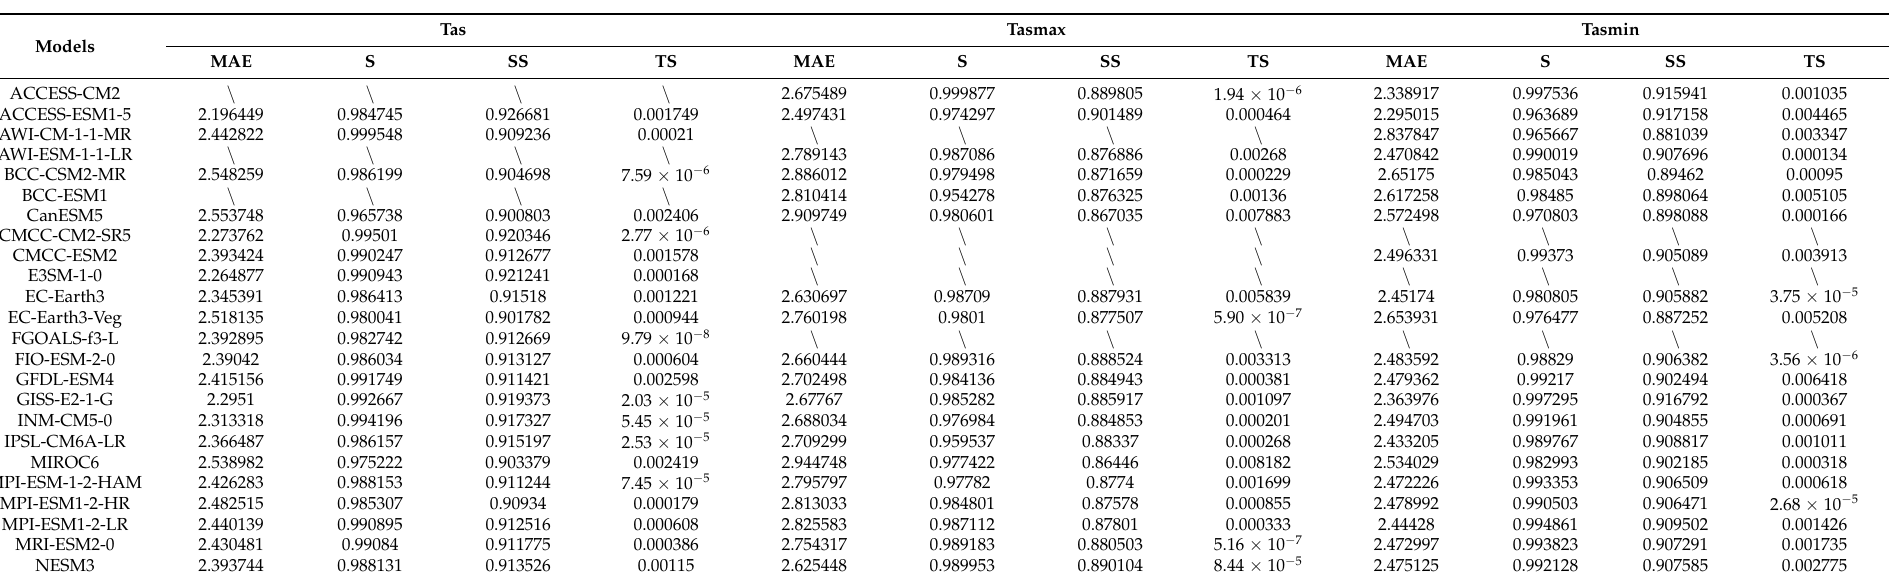
Table 3. Evaluation of the fitting error of downscaled climate models for monthly temperatures (tas/tasmax/tasmin) in the Yellow River Basin from January 1995 to December